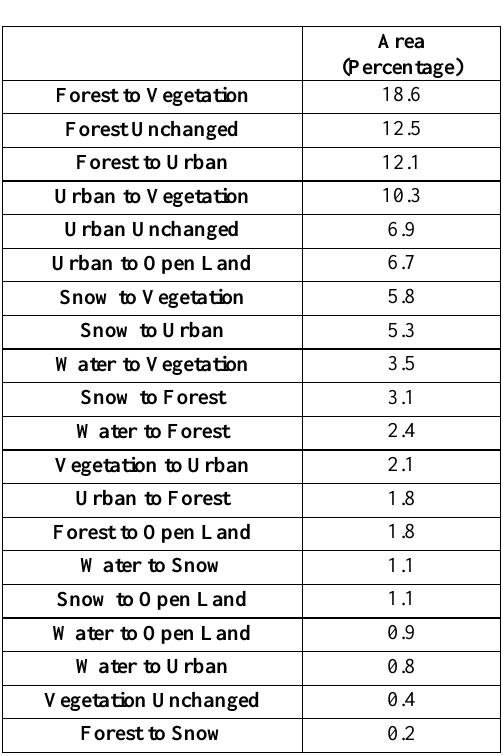
Table 4 LULC dynamics area (%) from 1990 to